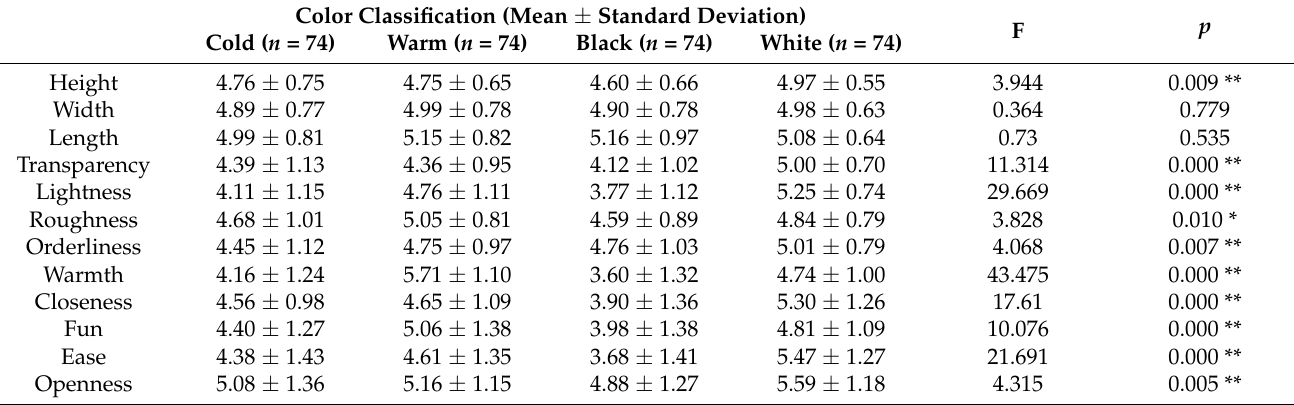
Table 11. Variance analysis of color